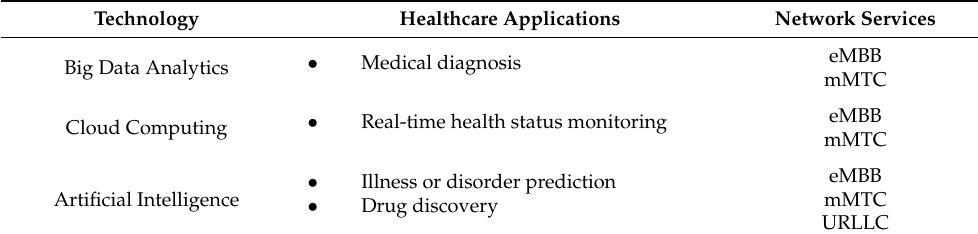
Table 3. Healthcare application domains and network services of emerging